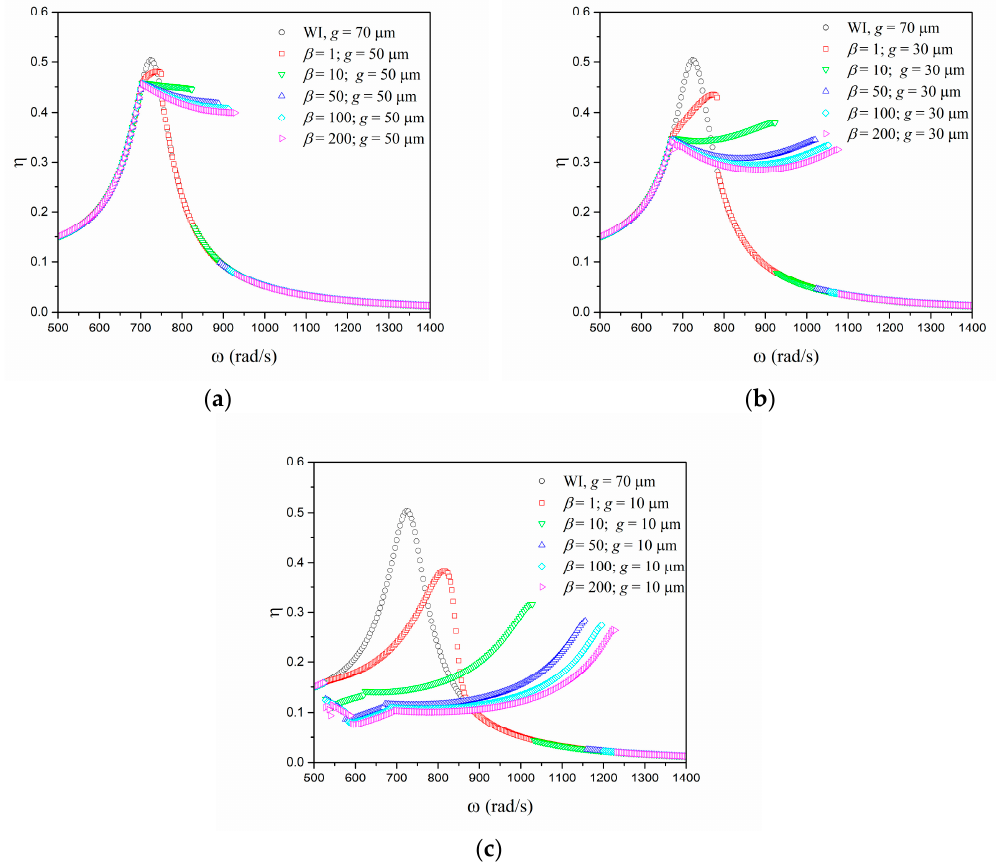
Figure 8. Efficiency versus forcing frequency: comparison between a linear model without impacts ( g = 70 µ m) and systems incorporating impacts with different values of support stiffness, k s : ( a ) 𝑔 = 50 μ m, ( b ) 𝑔 = 30 μ m, and ( c ) 𝑔 = 10 μ m.